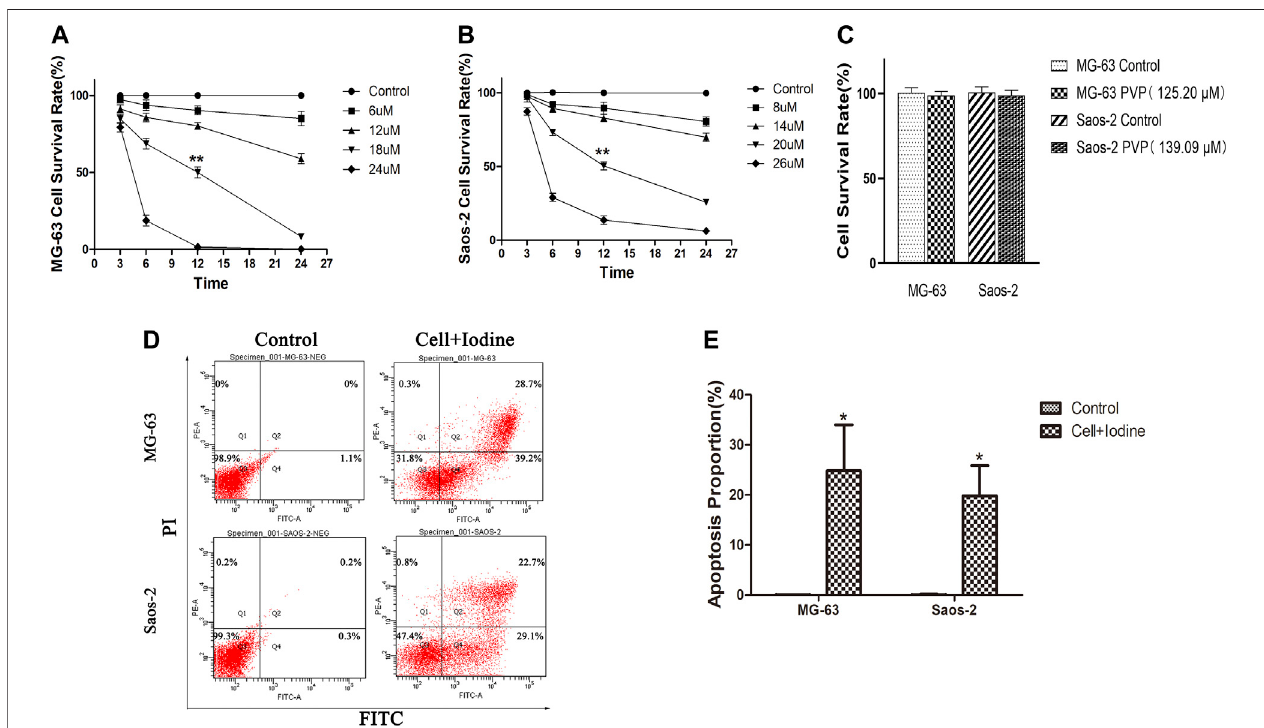
FIGURE 2 | Iodine induced apoptosis in OS cells. (A,B) After 3, 6, 12 and 24 h of treatment with iodine, the cell survival rate was assessed using a CCK-8 assay. TheIC 50 valuesofMG-63and Saos-2at12 hwere18and20 μ M,respectively(** p < 0.01). (C) ThecellsurvivalrateofMG-63and Saos-2cellsaftertreatmentwithPVP solution(125.20 and 139.09 µM) for12 h, whichcorrespondedto theiodine (18 and 20 µM)concentration used. (D) After 12 h oftreatment withiodine, the proportions ofcells(MG-63 andSaos-2)undergoingapoptosis wereanalysedby fl owcytometry afterstainingwithAnnexin V-FITC/PI. (E) Theproportion ofapoptotic OScells after treatmentwithiodine(* p < 0.05).Themeanpercentagesofcellsundergoing apoptosis(±SD) areshown.(OS, osteosarcoma; CCK-8,CellCounting Kit-8;IC 50 ,the median inhibitory concentration; PVP, polyvinylpyrrolidone; Annexin V-FITC/PI, Annexin V-FITC/PI Apoptosis Detection Kit; SD, standard deviation).